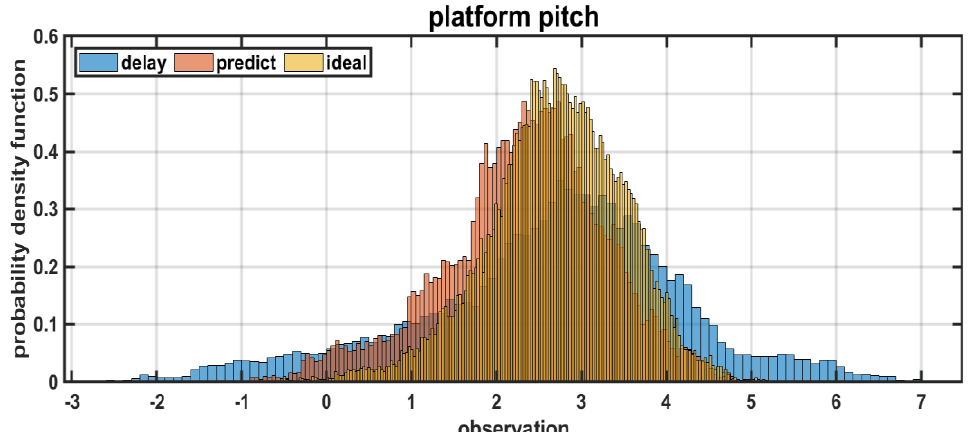
Figure 17. Histogram of platform pitch angle of floating offshore wind turbine by pitch controller.